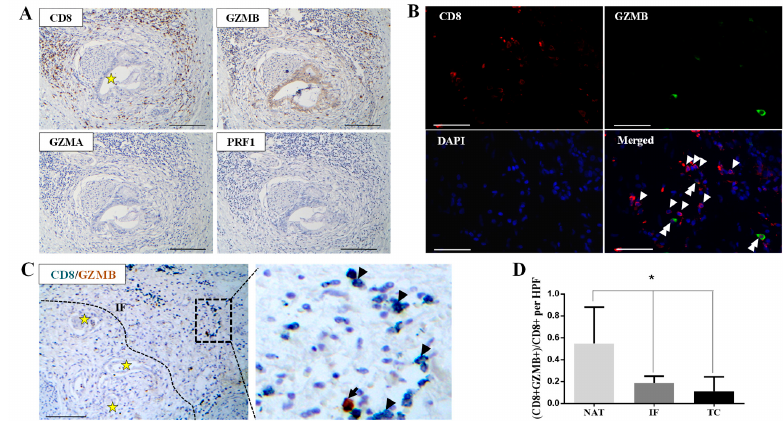
Figure 2. Decreased cytotoxic potential in CD8+ cells in PDAC. ( A ) Representative micrographs from serial section analysis demonstrating decreased granzyme A (GZMA), perforin 1 (PRF1), and granzyme B (GZMB) immunostaining in the IF in PDAC. Asterisk denotes perineural invasion by cancer glands. Scale bar: 100 μ m. ( B ) Representative micrographs showing the expression of CD8 (red) and granzyme B (green) in the tumor center (TC). Nuclei were counterstained with 4 ′ ,6-diamidino-2-phenylindole (DAPI) (blue). Arrowheads indicate CD8+ cells, and double arrowheads indicate CD8 +/ GZMB + cells. Scale bar: 100 µ m. ( C ) Representative micrographs showing GZMB (brown) and CD8 (emerald) expression assessed by double immunohistochemical staining in the invasive front (IF) from the PDAC case presented in (A). Arrowheads indicate CD8 + cells, and the arrow indicates a CD8 +/ GZMB + cell. Dashed line delineates the IF. Asterisks depict cancer glands. Scale bar: 200 µ m. ( D ) Quantification of the percentage of GZMB / CD8 double positive cells in the invasive front (IF), the tumor center (TC), and the normal parenchyma adjacent to the tumor (NAT). * p -value < 0.05. Data are expressed as mean ± STDEV (N =